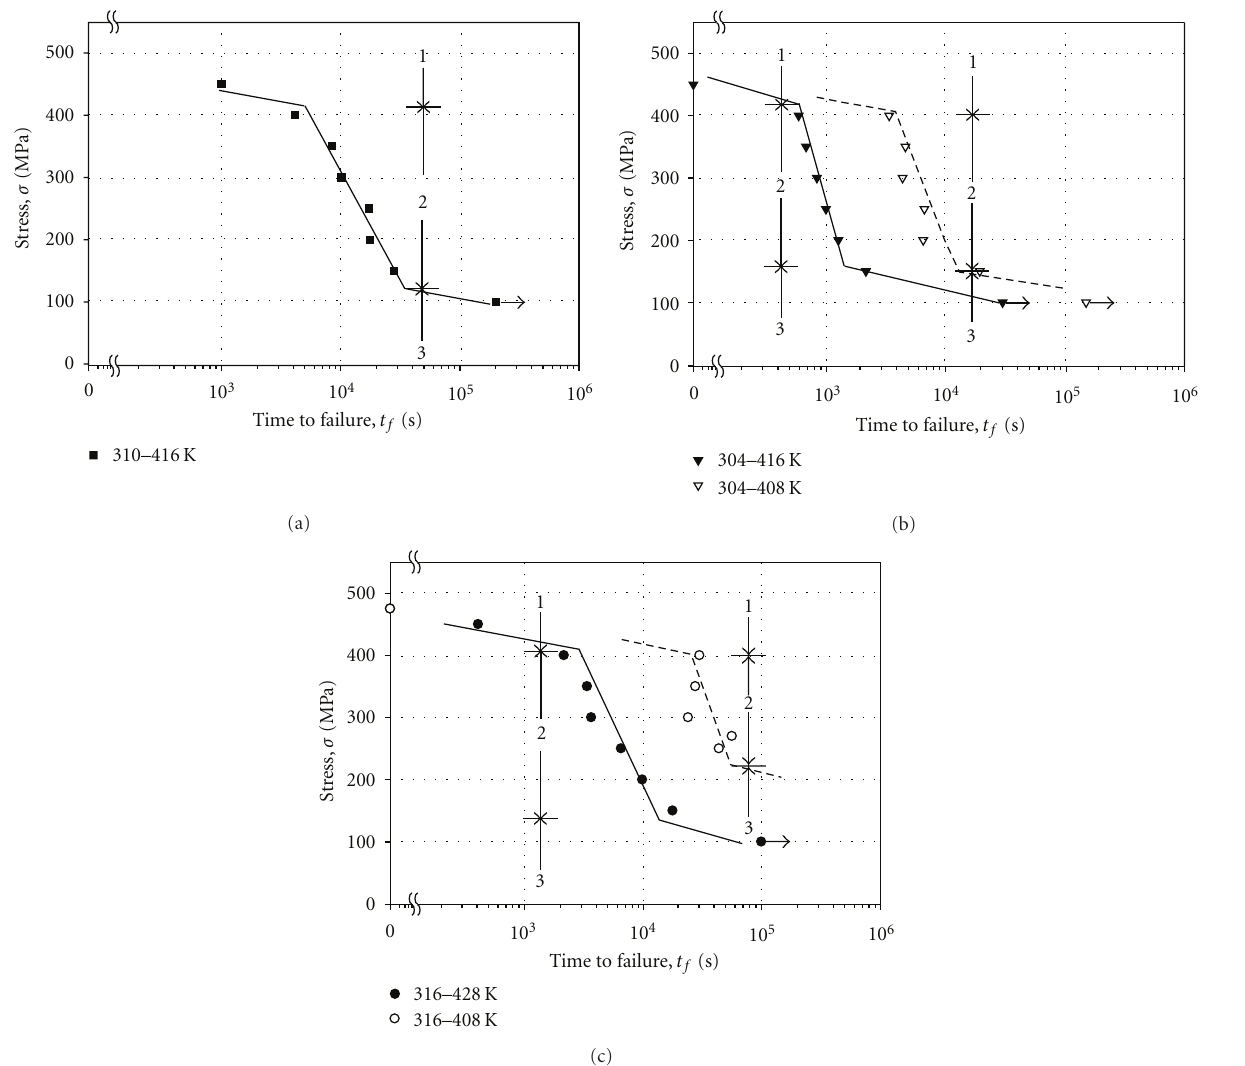
Figure 4: The relationship between applied stress ( σ ) and logarithm of time to failure ( t f ) for type 310, 304, and 316 steels in boiling saturated MgCl 2